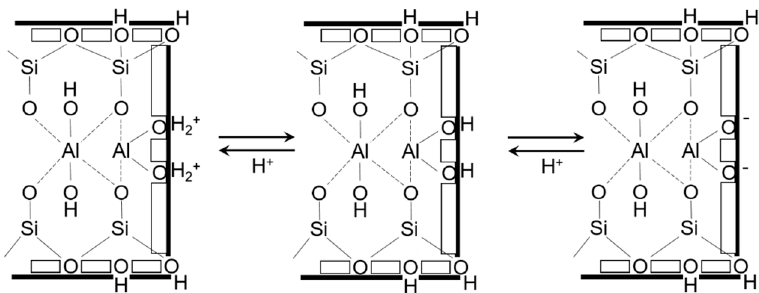
Figure 3. Reaction at the edge of phyllosilicate layers. Reprinted with permission from reference [33]. Cation exchange capacity (CEC) is a key to identify phyllosilicates reactivity. It quantifies